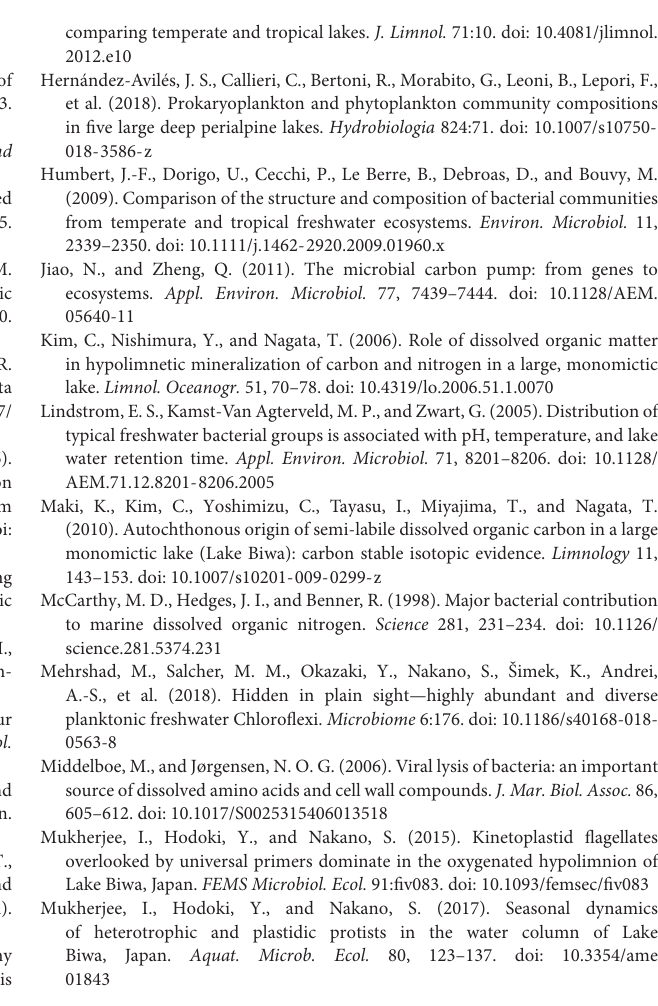
TABLE S2 | Summarized information for lakes where CL500-11 were investigated or detected. The first sheet contains lakes where CL500-11 have been enumerated with CARD-FISH, and the second sheet includes lakes where 16S rRNA sequences of CL500-11 have been retrieved. The references for the data are summarized in the third